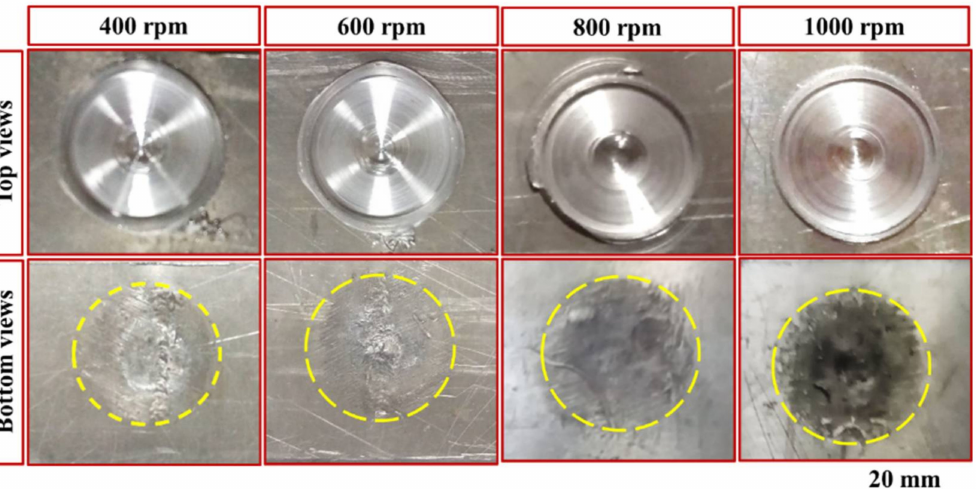
Figure 5. Typical appearances of both sides of dissimilar thin thickness FSSW AA6082-T6 lap joint samples at a constant dwell time of 3 s and different rotation